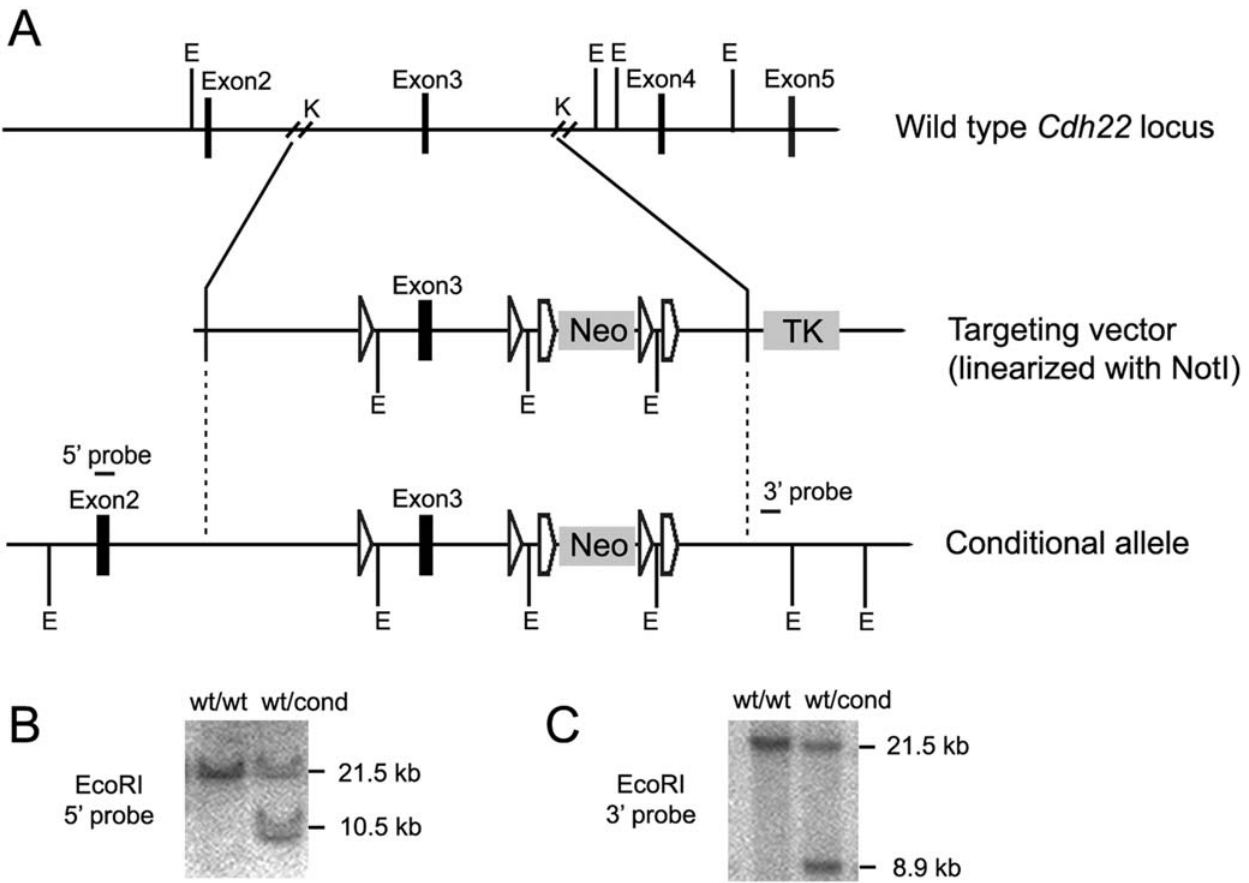
Figure 5. Targeting strategy for the conditional inactivation of the Cdh22 gene. ( A ) Restriction maps of the mouse wild type Cdh22 locus, the targeting vector, and the targeted allele. Relevant restriction sites: E, EcoRI; K, KpnI. Vertical dotted lines highlight homologous regions. ( B ) Southern analysis of genomic DNA from ES cells (EcoRI digestion), with the 5 9 -probe illustrating the 21.5 kb wild type (wt) and 10.5 kb targeted (cond) alleles. ( C ) Southern analysis of genomic DNA from ES cells (EcoRI digestion), with the 3 9 probe illustrating the 21.5 kb wild type (wt) and 8.9 kb targeted (cond) alleles.